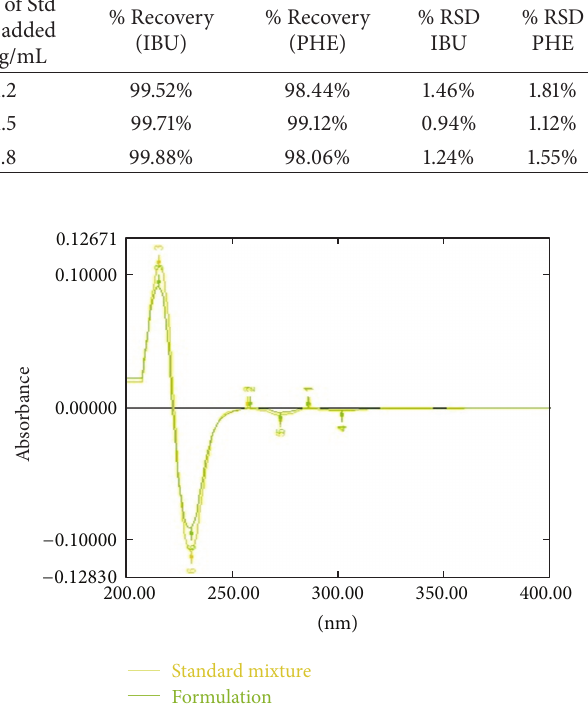
Figure 7: First derivative overlain spectra of IBU (30 𝜇 g/mL) and PHE (1.5 𝜇 g/mL) of marketed formulation, ADVIL and standard mixture. Table 4: Results of validation